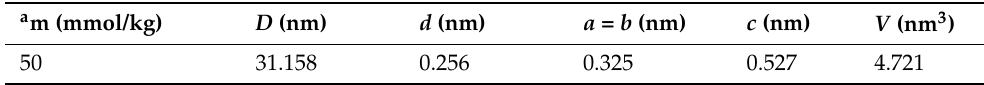
Table 1. Crystallite size (D), inter-planar spacing ( d ), lattice parameters ( a = b and c ), and volume ( V ) were calculated from the XRD measurements at 50 mmol/kg concentrations of Zn(NO 3 ) 2 · 6H 2 O.